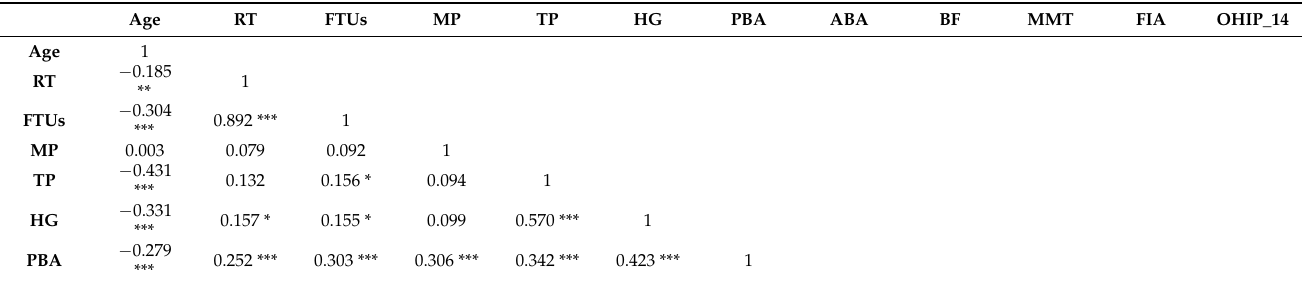
Table A2. Pearson’s correlation coefficient in all